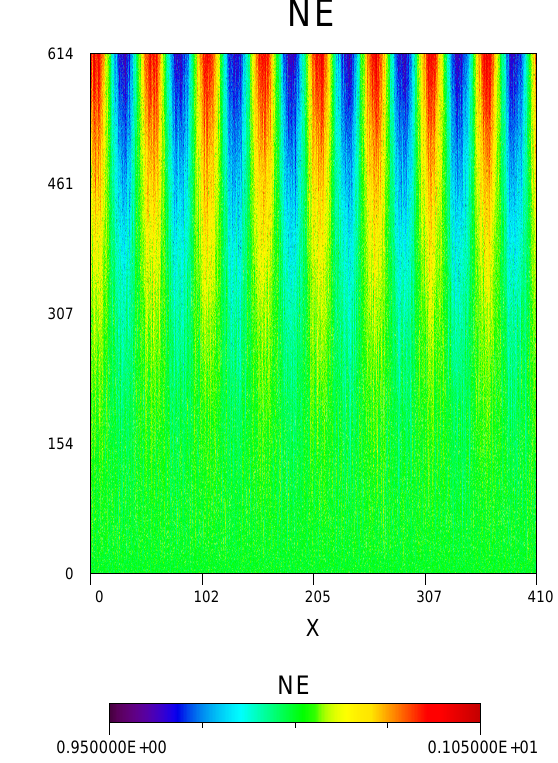
Fig. 9. AWC010. Temporal stack plot of the electron density n e (X,t)